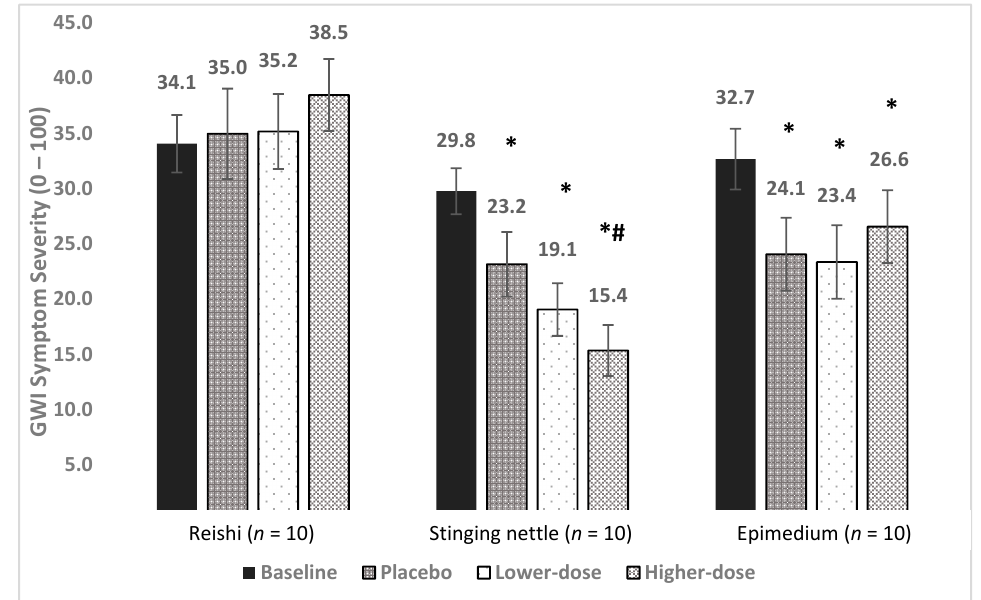
Figure 2. Main treatment effects of reishi, stinging nettle, and epimedium on GWI symptom severity. Average symptom levels (0–100) are presented for the baseline, placebo, lower-dose, and higher-dose conditions. * = significantly lower than baseline, *# = significantly lower than baseline and placebo ( p ’s < 0.05).